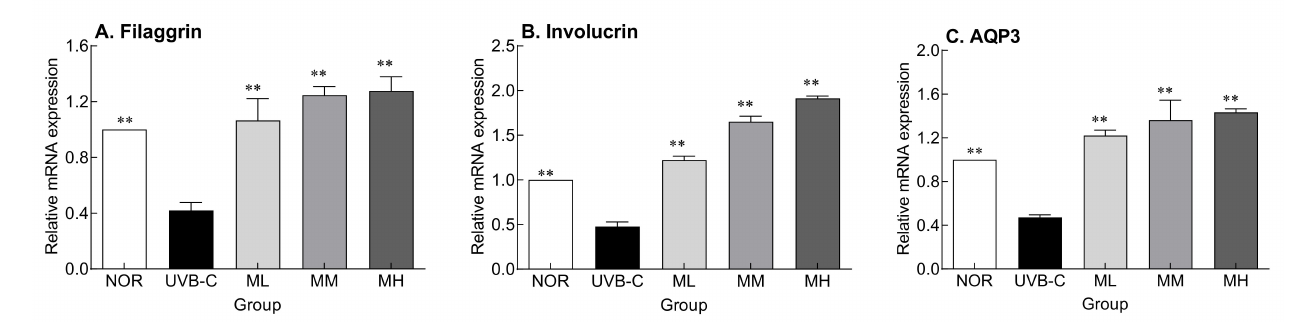
Figure 3. Effects of milk phospholipids on the expression of filaggrin ( A ), involucrin ( B ), and AQP3 ( C ) in UVB-irradiated hairless mice. NOR: oral administration of saline without UVB irradiation; UVB-C: oral administration of saline under UVB irradiation; ML: oral administration of low-dose (50 mg/kg b.w.) milk phospholipids under UVB irradiation; MM: oral administration of medium- dose (100 mg/kg b.w.) milk phospholipids under UVB irradiation; MH: oral administration of high-dose (150 mg/kg b.w.) milk phospholipids under UVB irradiation. Data are expressed as means ± standard error ( n = 6). ** p < 0.01 vs. UVB-C group (Tukey’s test). AQP3: